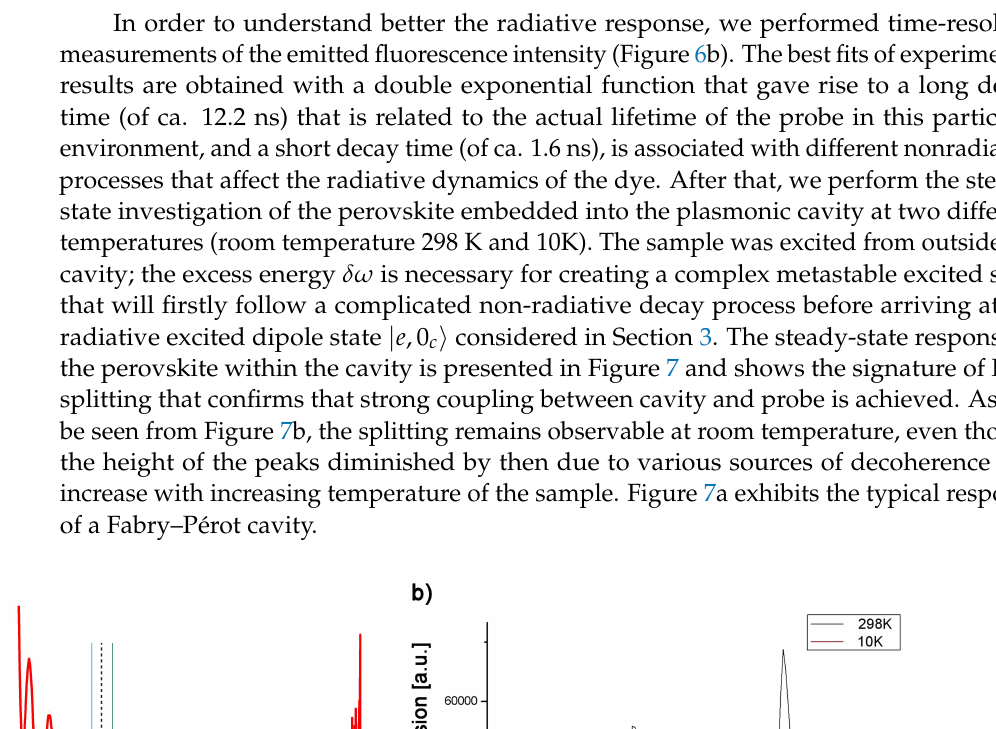
Figure 6. ( a ) Fluorescence steady state spectrum of perovskite in solution; ( b ) Fluorescence decay time response of the perovskite in solution fitted with a double exponential function.